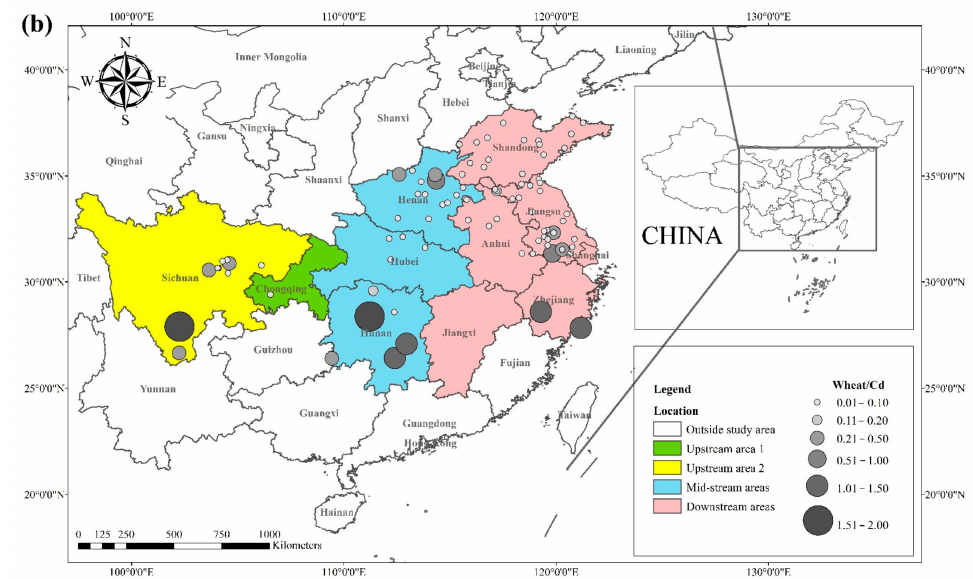
Figure 1. Distribution of Cd concentrations in ( a ) rice and ( b ) wheat, based on data collected from previous